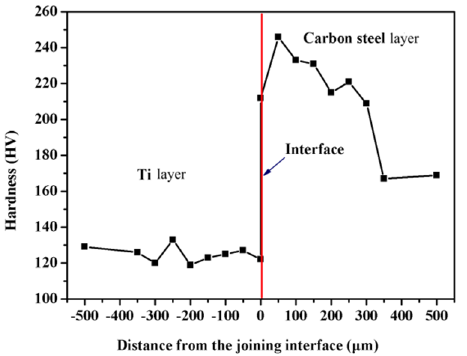
Figure 6. Hardness test results of the interface in the clad plate.